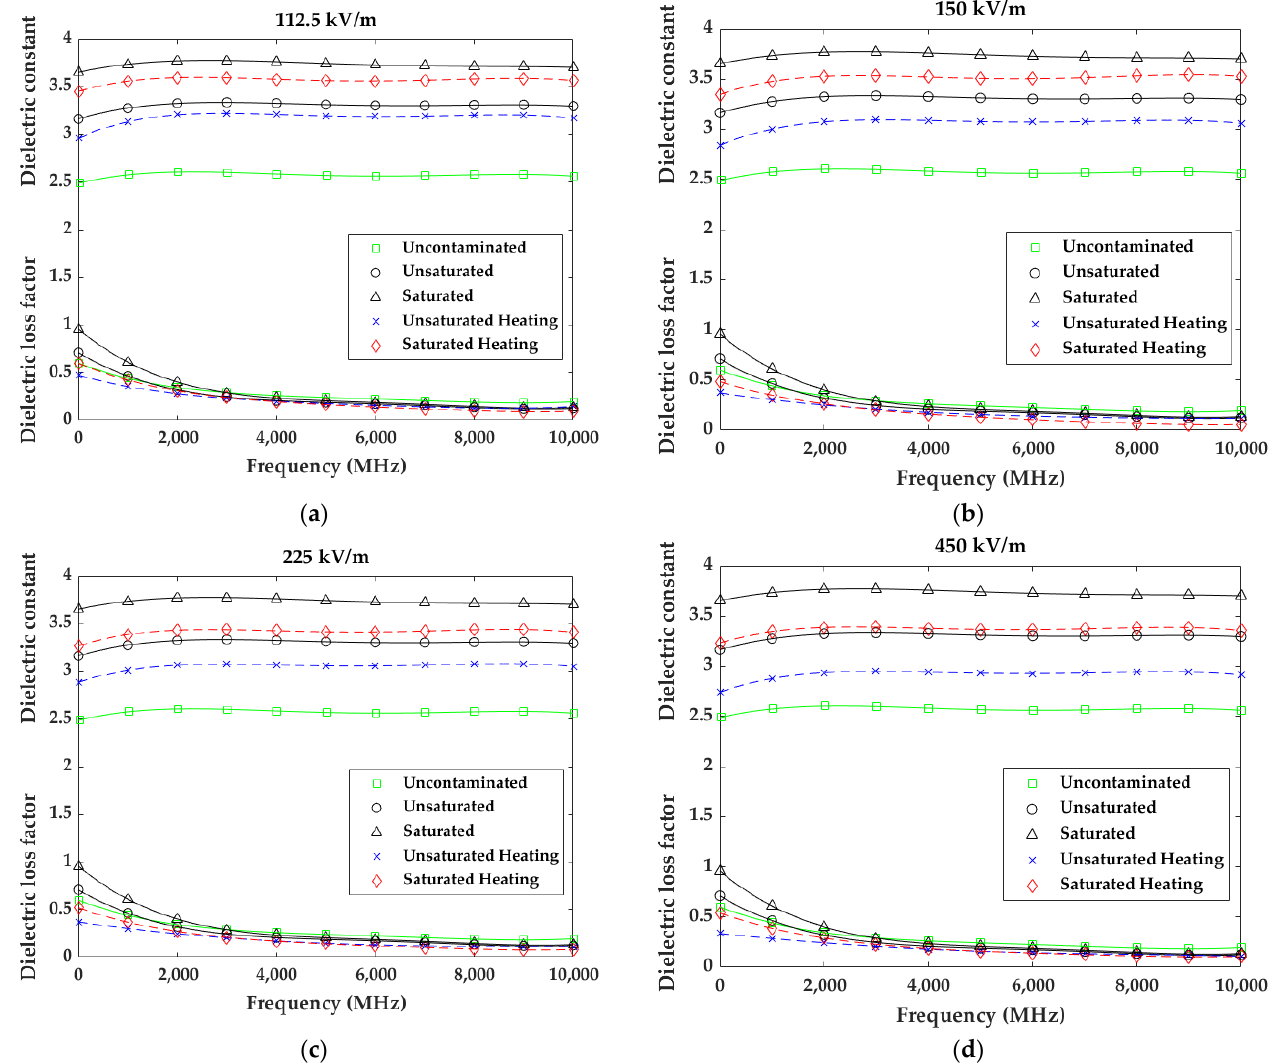
Figure 5. Dielectric properties of the unsaturated contaminated soil and the saturated contaminated soil samples before and after RF heating process compared with the soil without the commercial grade diesel B7 as the reference line where ( a ) is based on electric field of 112.5 kV/m; ( b ) is based on electric field of 150 kV/m; ( c ) is based on electric field of 225 kV/m; ( d ) is based on electric field of 450 kV/m. Table 2. Dielectric properties of heated soil samples based on the highlighted frequencies.